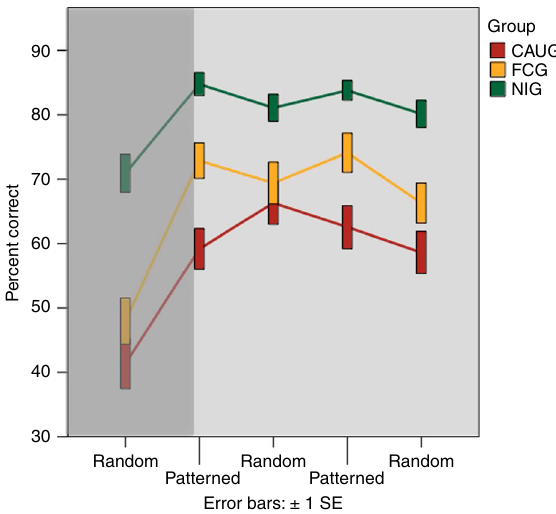
Fig. 3 Percent correct by group across all blocks of the serial reaction time task. If the block was “ random ” or “ patterned ” is indicated on the x -axis. Implicit learning is measured as the degree to which accuracy improves on patterned compared to random blocks The fi rst block (random) is shaded because this block was not included in analyses as performance on this block represents basic learning of the task. Bars are error bars (±1 SEM; N = 44 FCG; N = 37 CAUG; N = 42 NIG)